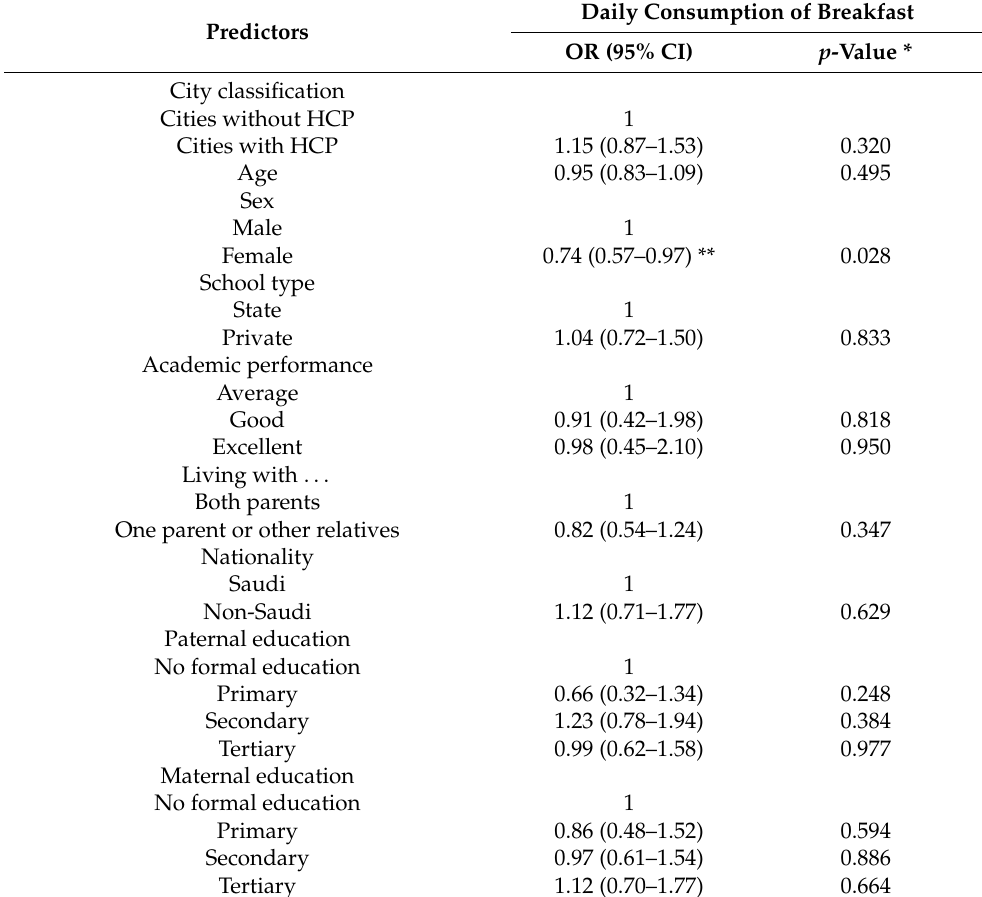
Table 3. Predictors of daily consumption of breakfast among adolescents in Qassim, Saudi